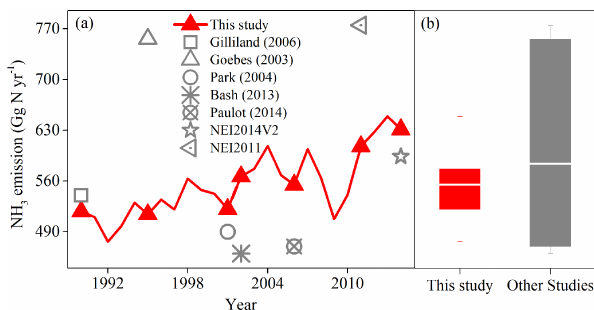
Figure 8. Comparison of annual NH 3 emission estimates between this study and others. (a) Paired comparison between our result and individual research; (b) boxes include 25%–75% of NH 3 emission of all chosen years estimated by our study and other studies, respec- tively. White lines are mean values, and whiskers represent the min– max range of data. NH 3 emission estimated by Paulot et al. (2014) represents the average of 2005–2008, against which we compared our estimate of 2006.